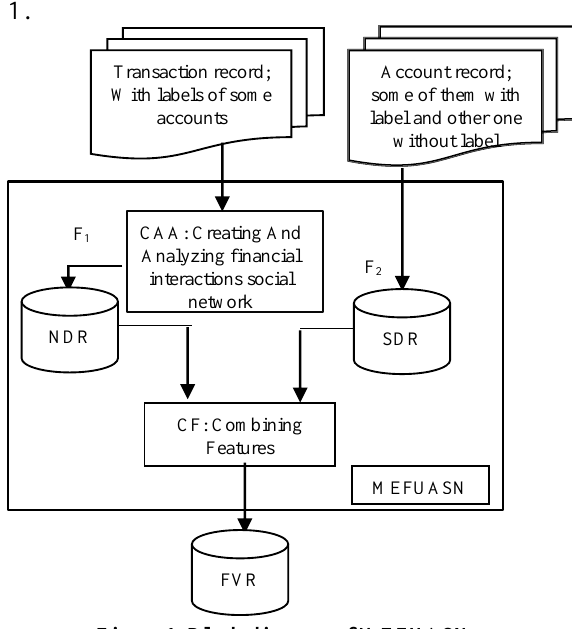
Figure 1. Block diagram of